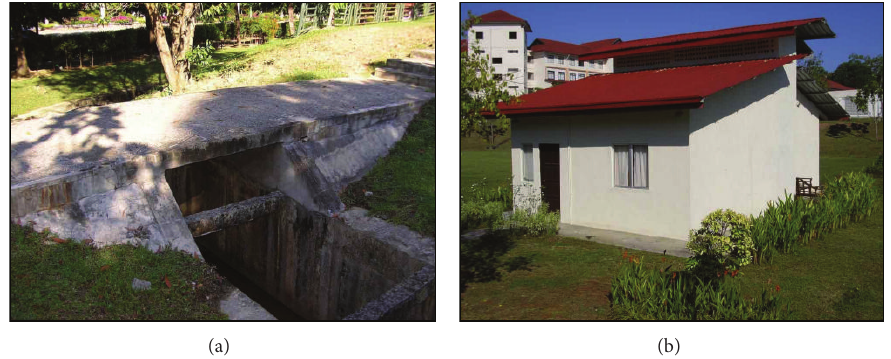
Figure 3: (a) Footbridge and (b) low cost house constructed using OPS concrete